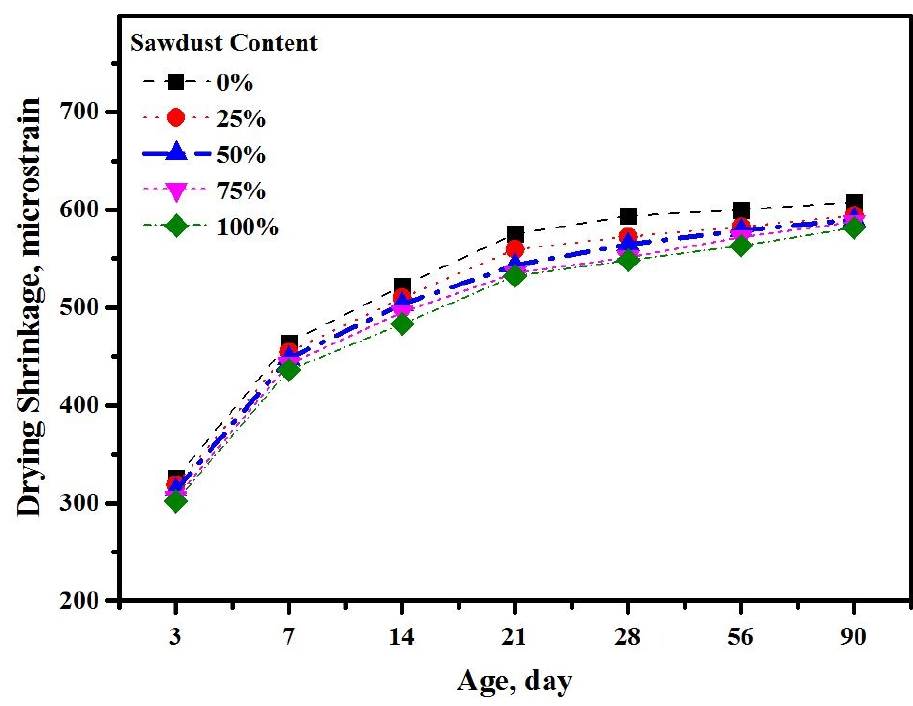
Figure 16. Drying shrinkage of the prepared concrete with various sawdust contents.